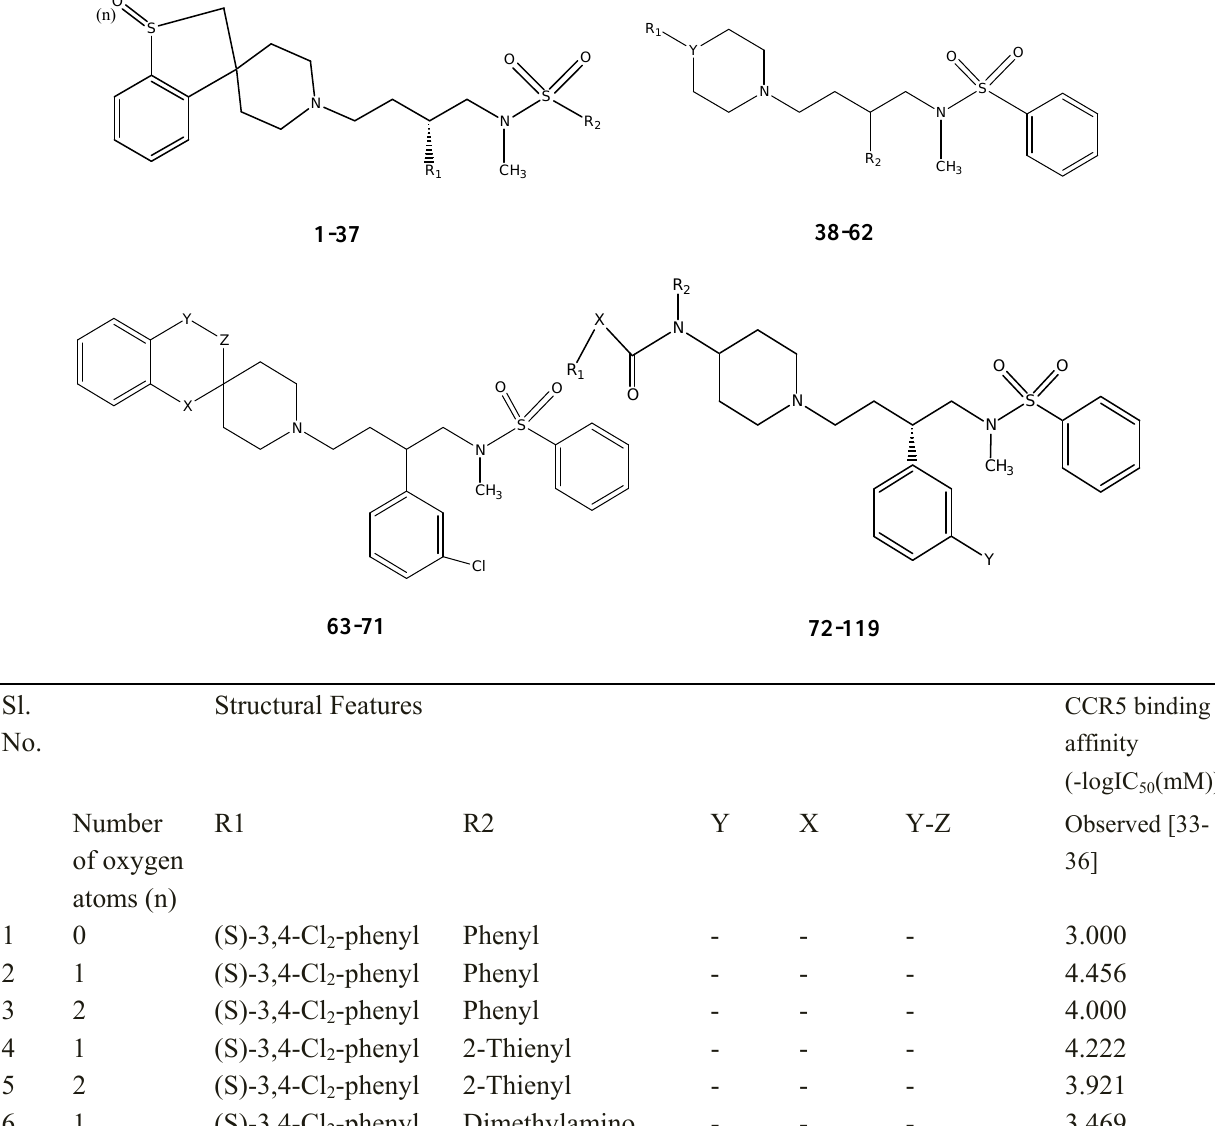
Table 1. Structural features and CCR5 binding affinities of piperidine containing